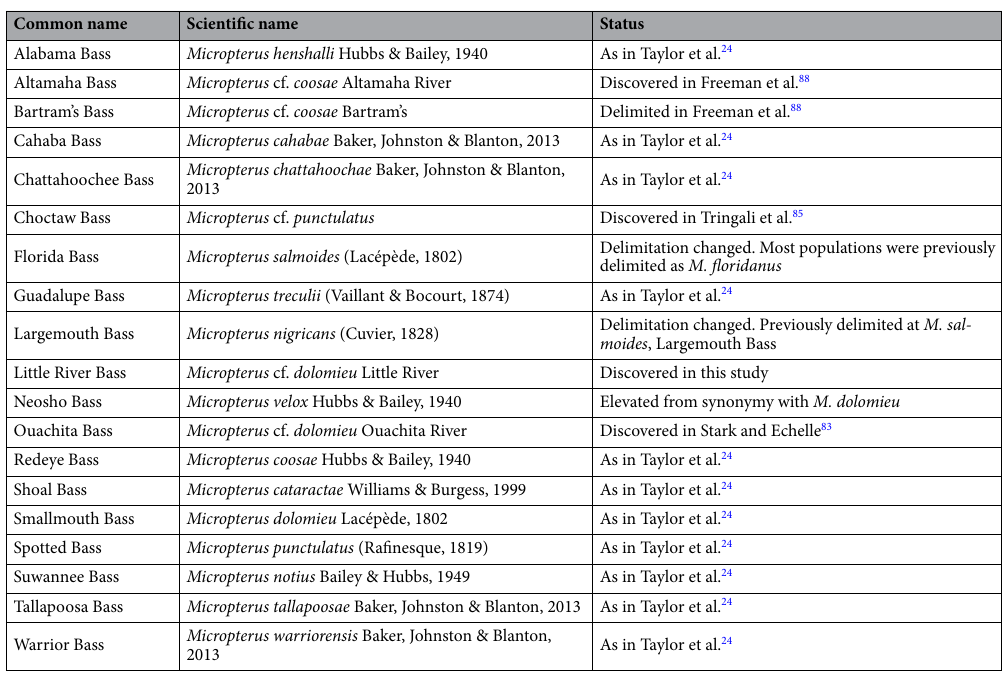
Table 1. List of delimited species of Micropterus . Status indicates if delimitation is different from Taylor et al. 24